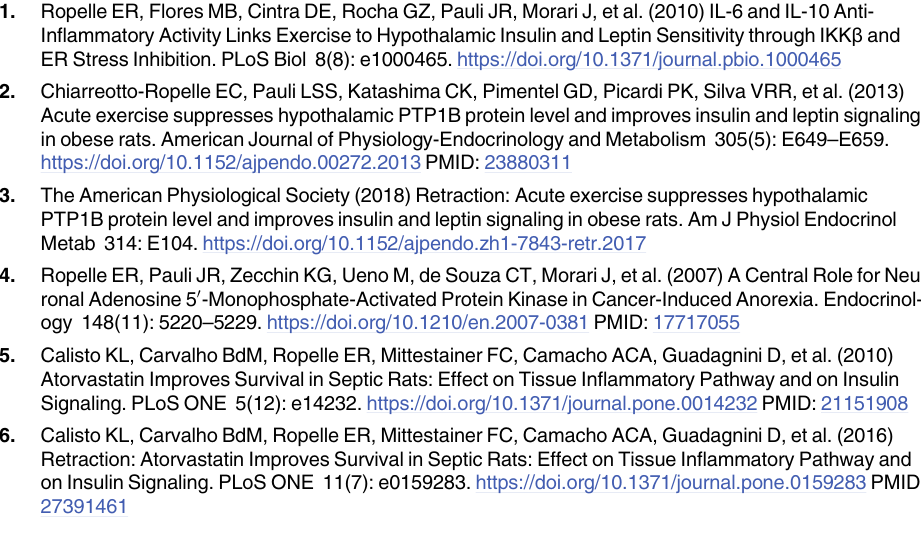
The Fig 2F IB: pJak2Tyr1007/8 panel reports material from [4], published in 2007 by the Endocrine Society, which is not offered under a CC-BY license and is therefore excluded